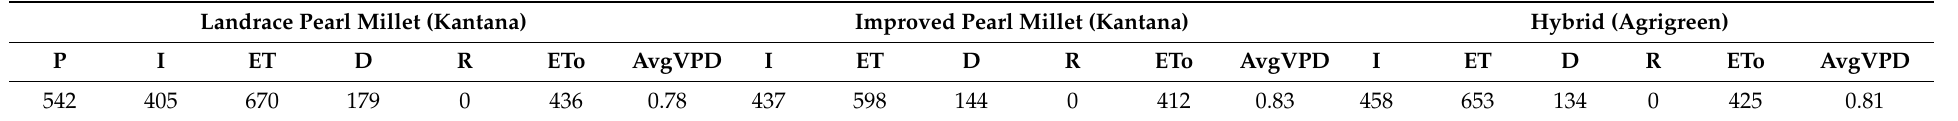
Table 2. Seasonal soil water balance (mm) for three pearl millet varieties (December–April of 2017/2018). Precipitation (P) and irrigation (I), evapotranspiration (ET), drainage (D), runoff (R), evapotranspiration (ET o ) and average vapour pressure deficit is in Pascal (Pa) (Avg. VPD). Landrace Pearl Millet (Kantana) Improved Pearl Millet (Kantana) Hybrid